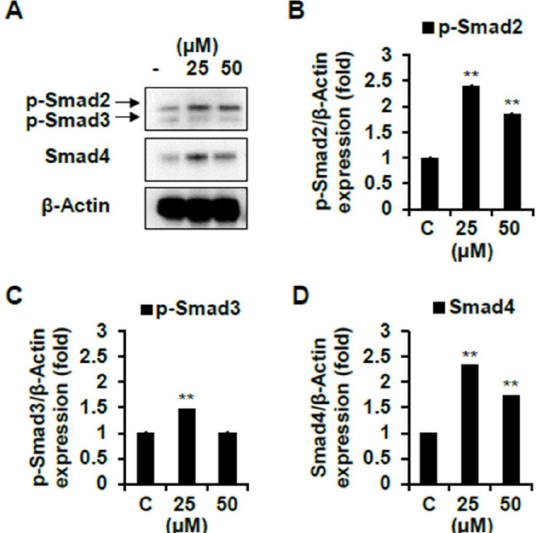
Figure 10. Skeletal muscle cell differentiation activity of compound 7 on C2C12 differentiated cells. The levels of p-Smad2/3 and Smad4 proteins were determined using a Western blot analysis. Every level of proteins versus β -Actin were measured by densitometry. C, control. Experiments were performed in triplicate and the data were expressed as mean ± SE; ** p < 0.01 as compared to the control (untreated cells).